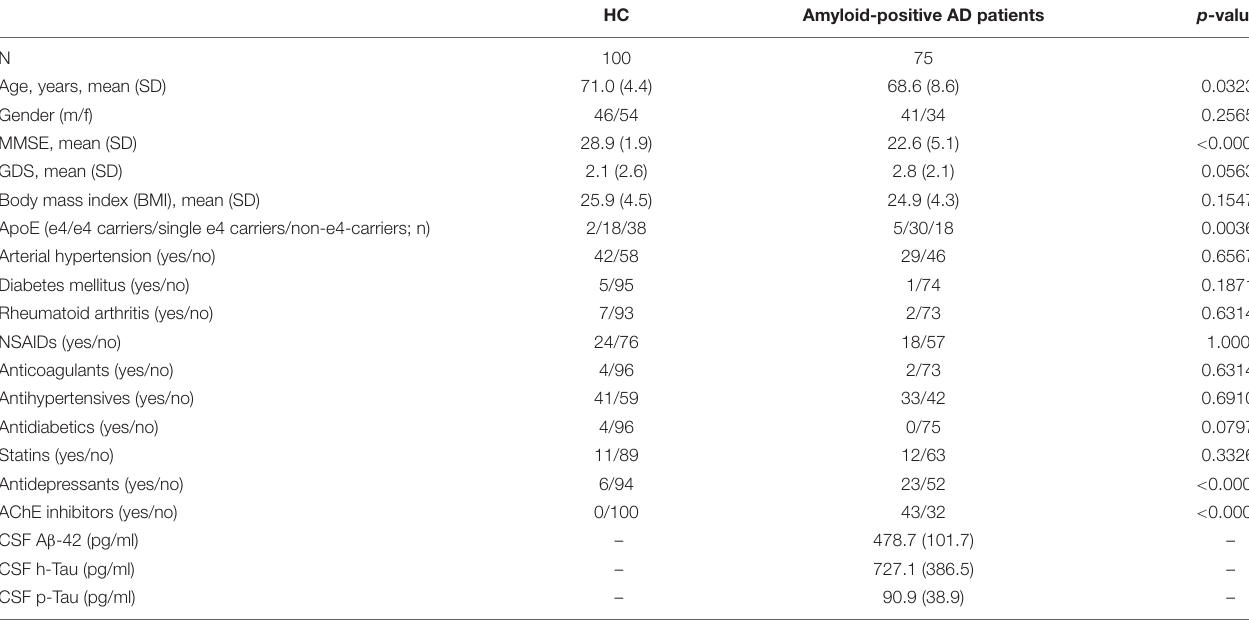
TABLE 1 | Clinical and demographic characteristics of healthy control (HC) individuals and amyloid-positive Alzheimer’s disease (AD) patients. HC Amyloid-positive AD patients